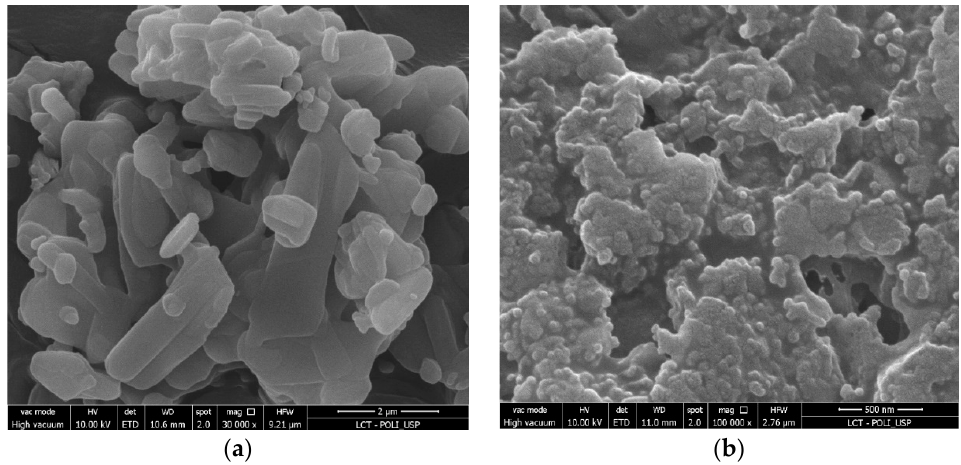
Figure 5. Microphotography of raw material besifloxacin ( a ) and besifloxacin nanocrystals ( b ).